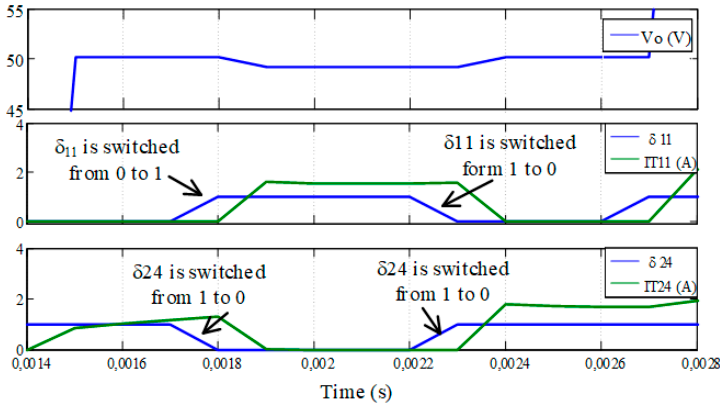
Figure 6. Output voltage V o (t), currents IT11 and IT24, and command of the switches T11 and T24 (Zoom 1).